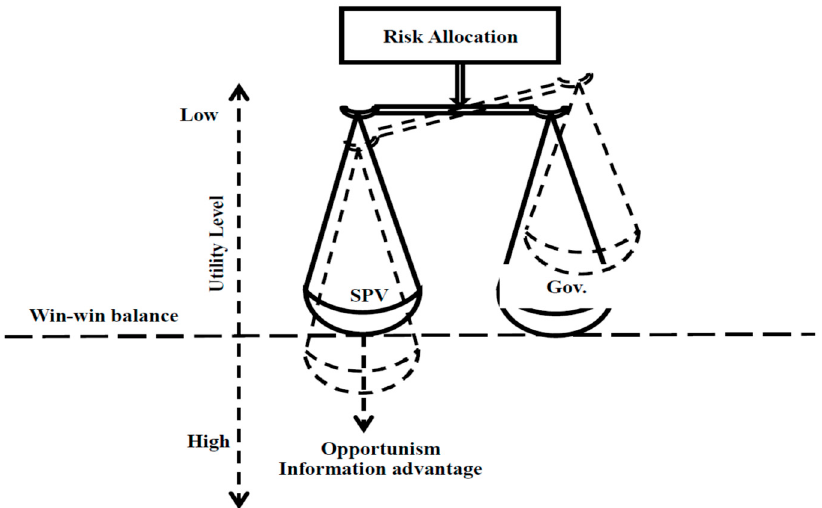
Figure 3. The role of risk allocation to achieve a win–win balance [7]. Note: SPV is special purpose vehicle and Gov is government.